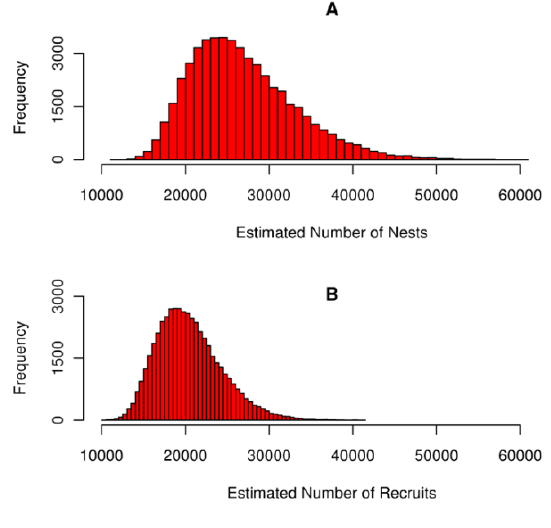
Fig. 3 . Distribution of estimated A) number of nests, and